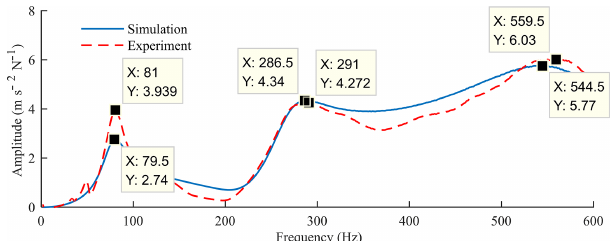
Figure 8. The simulated and experimentally measured FRFs of the